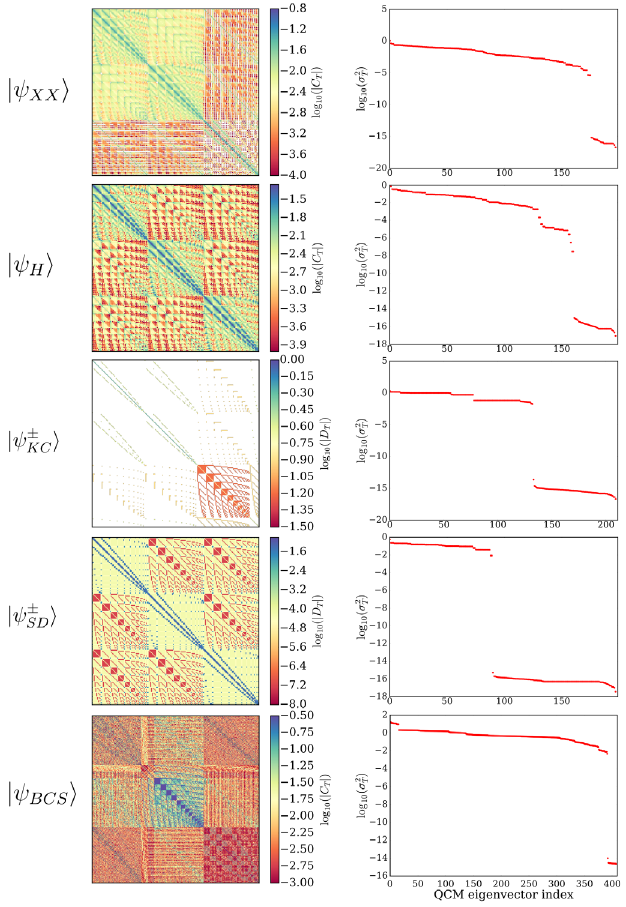
FIG. 7. A summary of phase expansion results obtained in this work. In each row, we show the target state(s) provided as input to EHC (and DEHC), the QCMs C T [and DQCMs D T (see Supplemental Material [65])] we calculated, and their spectra on a log scale. The eigenvectors of a QCM (or DQCM) are vectors of coupling constants that correspond to Hamiltonians with variance σ 2 T under the target state j ψ T i . The QCM for j ψ in the bottom row was statistically estimated using variational Monte Carlo, while the others were computed with matrix product